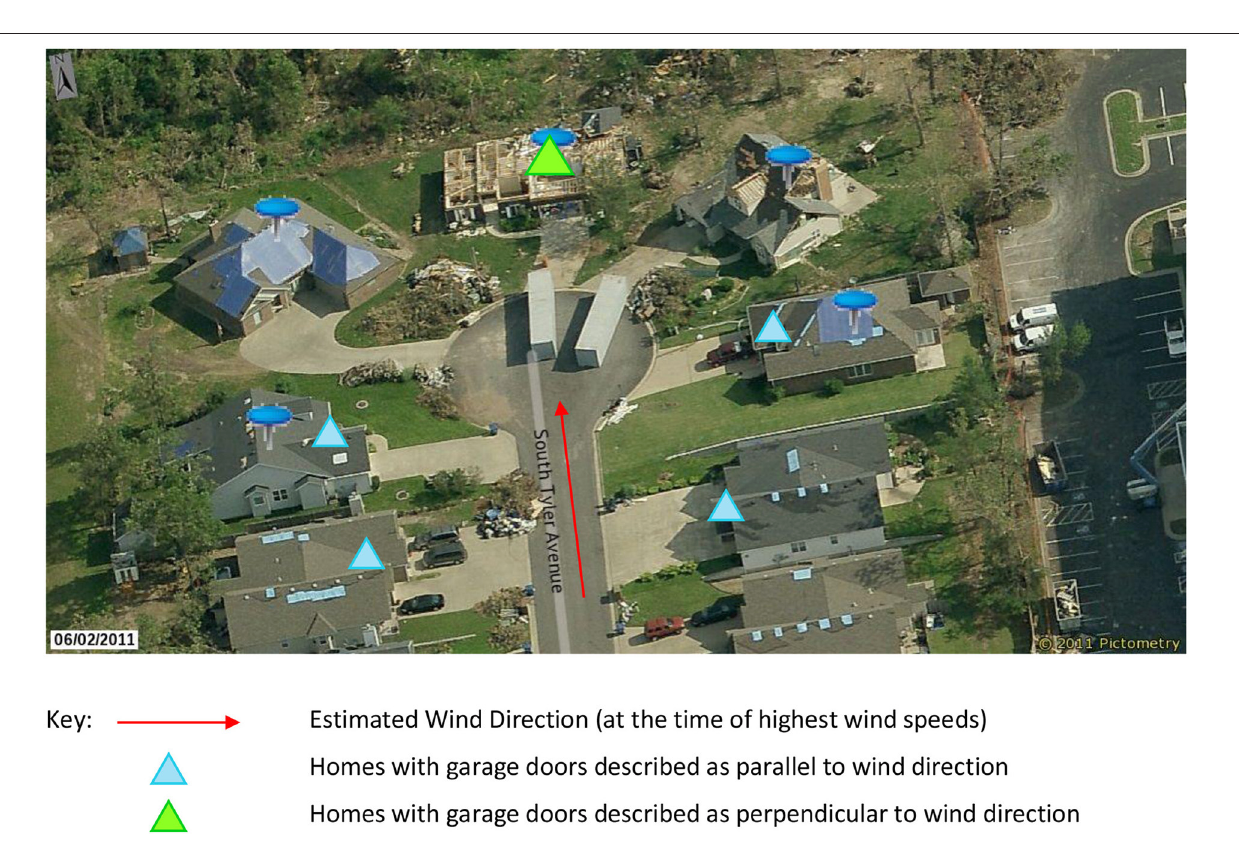
Frontiers in Built Environment |